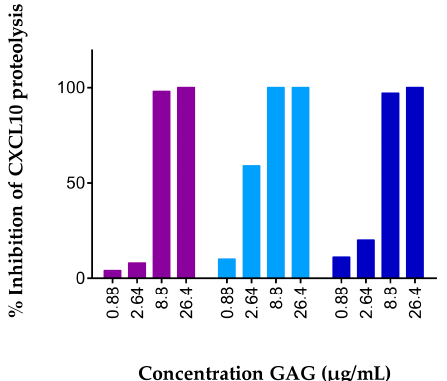
Figure 1. GAGs dose-dependently protect CXCL10 from cleavage by CD26. Recombinant human CXCL10 (20 µg/mL) was incubated with 12.5 U/L natural human CD26 and 0.88 to 26.4 µg/mL heparan sulfate (violet, ● ), heparin DP30 (blue, ● ), or heparin DP8 (deep blue, ● ), in 50 mM Tris buffer supplemented with 1 mM EDTA (pH 7.5). Incubation of CXCL10 with CD26 in the absence of GAG was used as a control. Reactions were terminated after 2 h by acidification to 0.08% ( v / v ) trifluoroacetic acid (TFA). The ratio of truncated CXCL10 (3–77) over corresponding intact chemokine was determined with automated NH 2 -sequencing. Results are represented as percentages of GAG- mediated inhibition of proteolysis of CXCL10 by CD26.